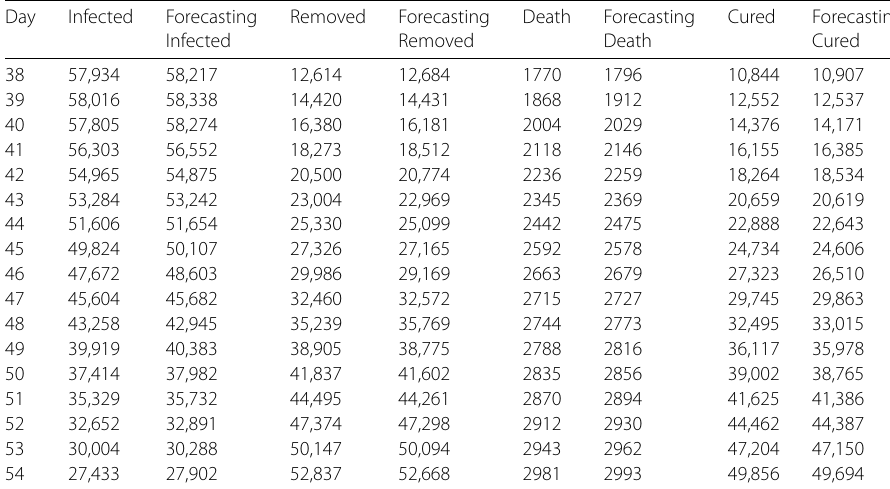
Table 2 The forecasting infected and removed from February 16 to March 3 Day